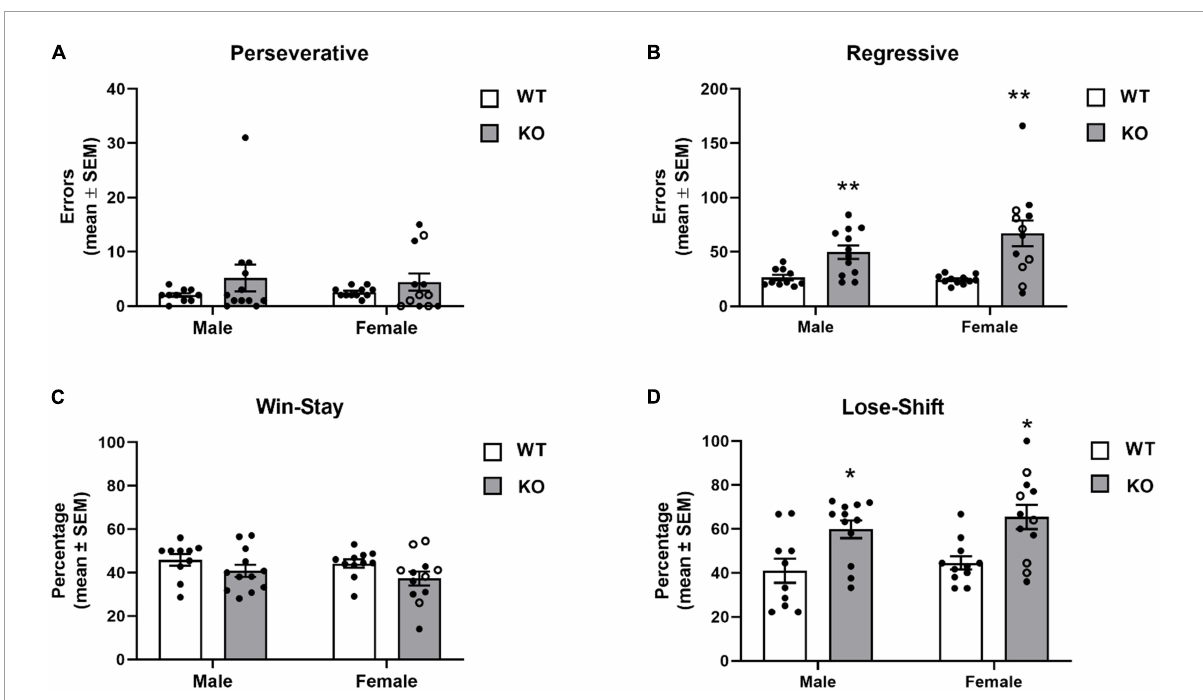
FIGURE7 Error committed during reversal learning of a spatial discrimination (80/20 probabilistic learning procedure). (A) Mean ( ± SEM) perseverative errors during reversal learning. Wildtype (WT) and Fmr1 -knockout (KO) mice did not differ in the number of perseverative errors. (B) Mean ( ± SEM) regressive errors during reversal learning. Male and female Fmr1 -KO mice committed more regressive errors compared to that of WT male and female during reversal learning. (C) Mean ( ± SEM) percentage win-stay probabilities during reversal learning. Fmr1 -KO mice had lower win-stay probabilities than WT mice. (D) Mean ( ± SEM) percentage lose-shift probabilities during reversal learning. Both male and female Fmr1 -KO mice had higher lose-shift probabilities than WT male and female mice. * p < 0.05 vs. WT male and female mice; ** p < 0.01 vs. WT male and female mice. In the female Fmr1- KO group, • , heterozygous mice and ◦ , homozygous